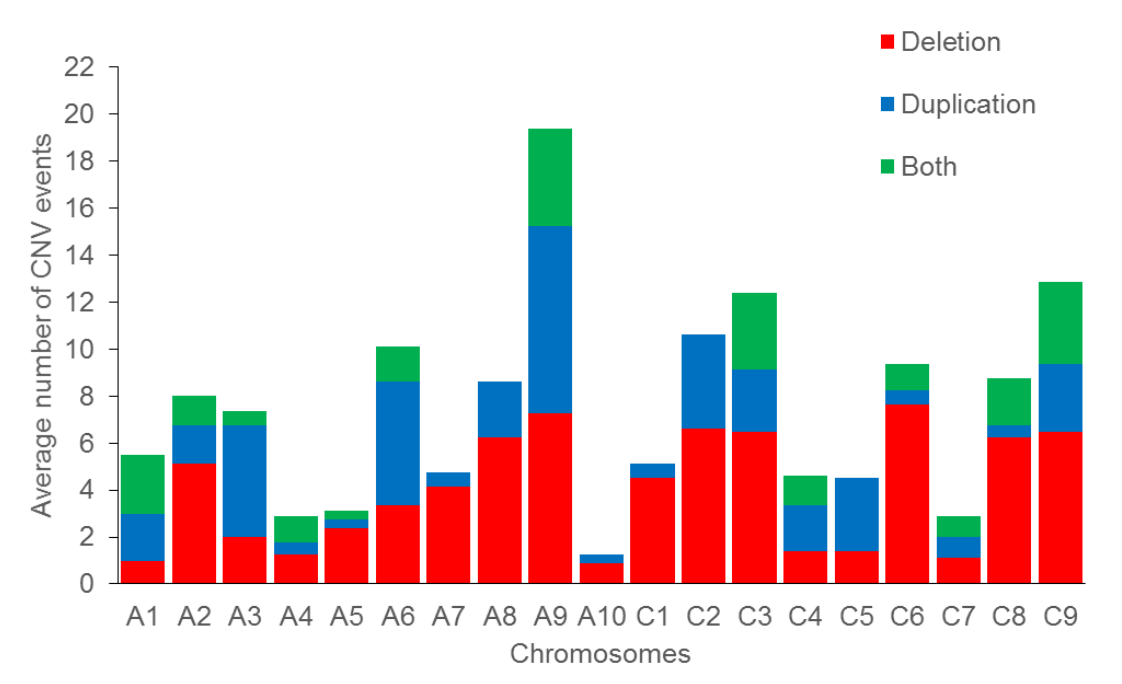
Figure 4. The average number of CNV events (i.e., deletion, duplication and both deletion and duplication) per chromosome of eight winter type and blackleg resistant B. napus lines. Each colour (bin) represents a different CNV events and the bars show the average number of CNVs falling into each event bin. Both: Where both deletion and duplication events occurred.